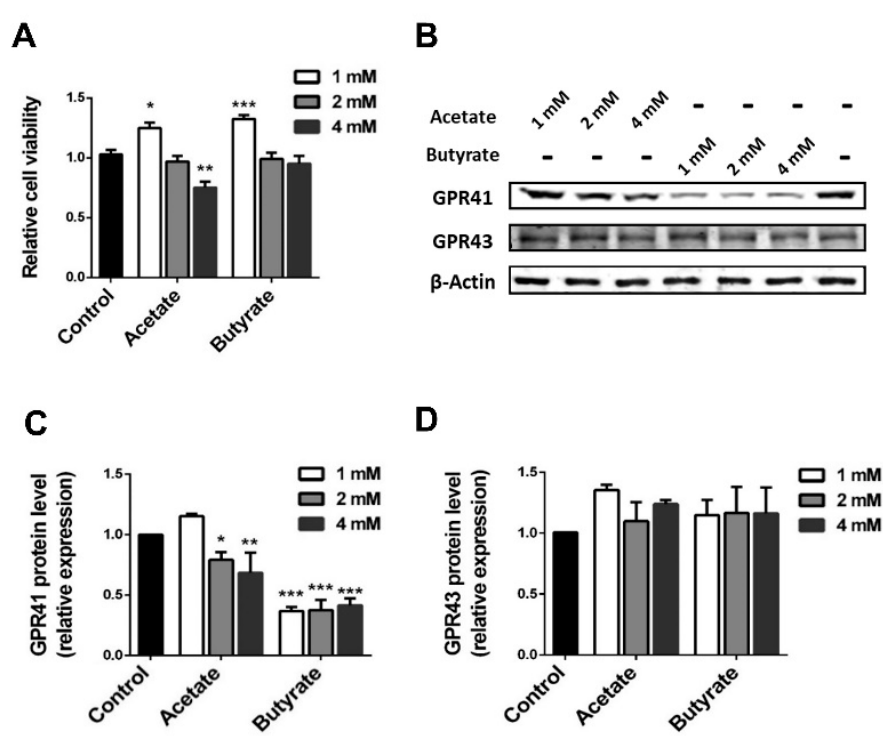
Figure 2. Effects of acetate and butyrate on mouse insulinoma MIN6 β -cell viability and expression of GPR41 and GPR43. MIN6 cells incubated with acetate or butyrate for 24 h. ( A ) Cell viability was determined by WST-1 assay. The expressions of GPR41 and GPR43 were investigated by Western blot ( B ). Western blot results were analyzed by using Image J gradation analysis of GRP41 ( C ) and GRP43 ( D ). Results are represented as mean ± SEM ( n = 5). The statistical differences were quantified using one-way ANOVA analysis with Newman–Keuls multiple comparisons test (* p < 0.5, ** p < 0.01, *** p < 0.001, compared to the untreated control group).